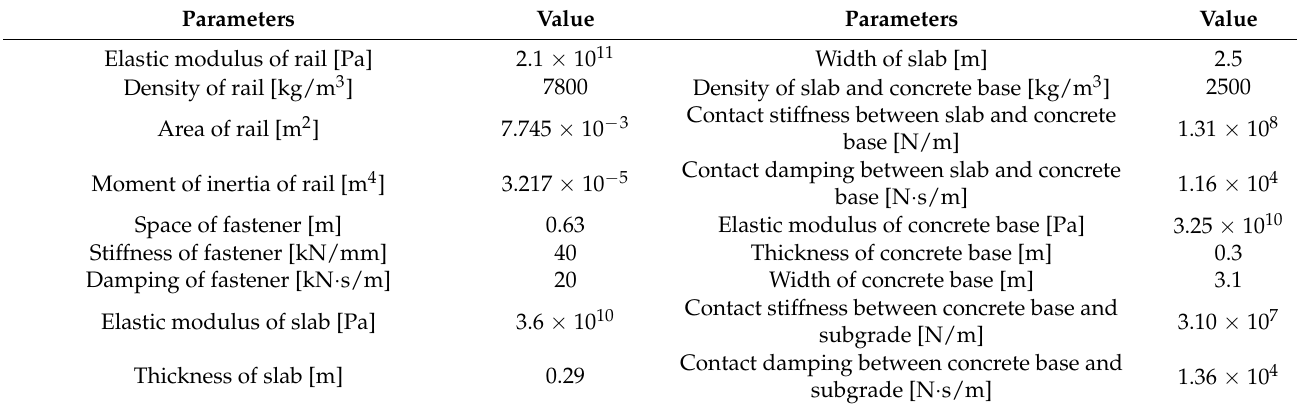
Table 2. Calculation parameters of the CRTS III slab track-subgrade